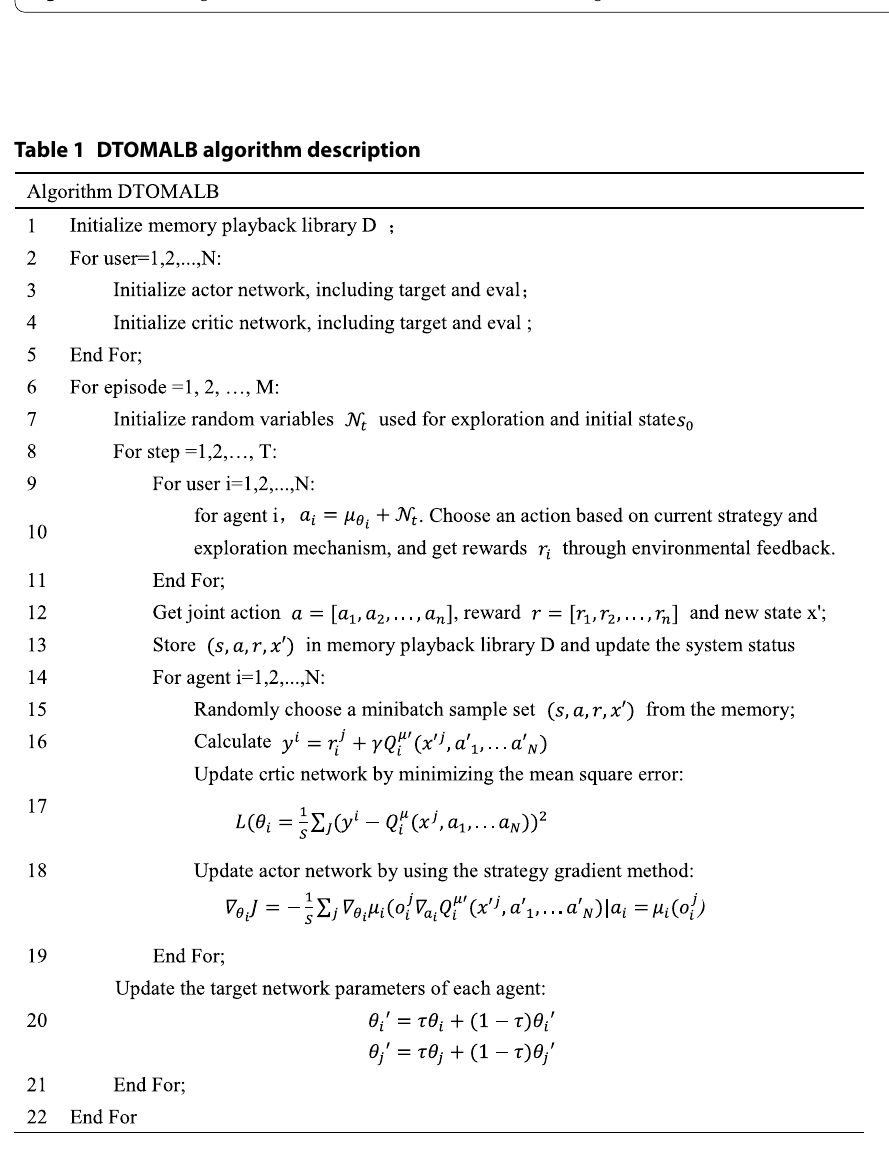
Fig. 4 Schematic diagram of the network structure of the DTOMALB algorithm